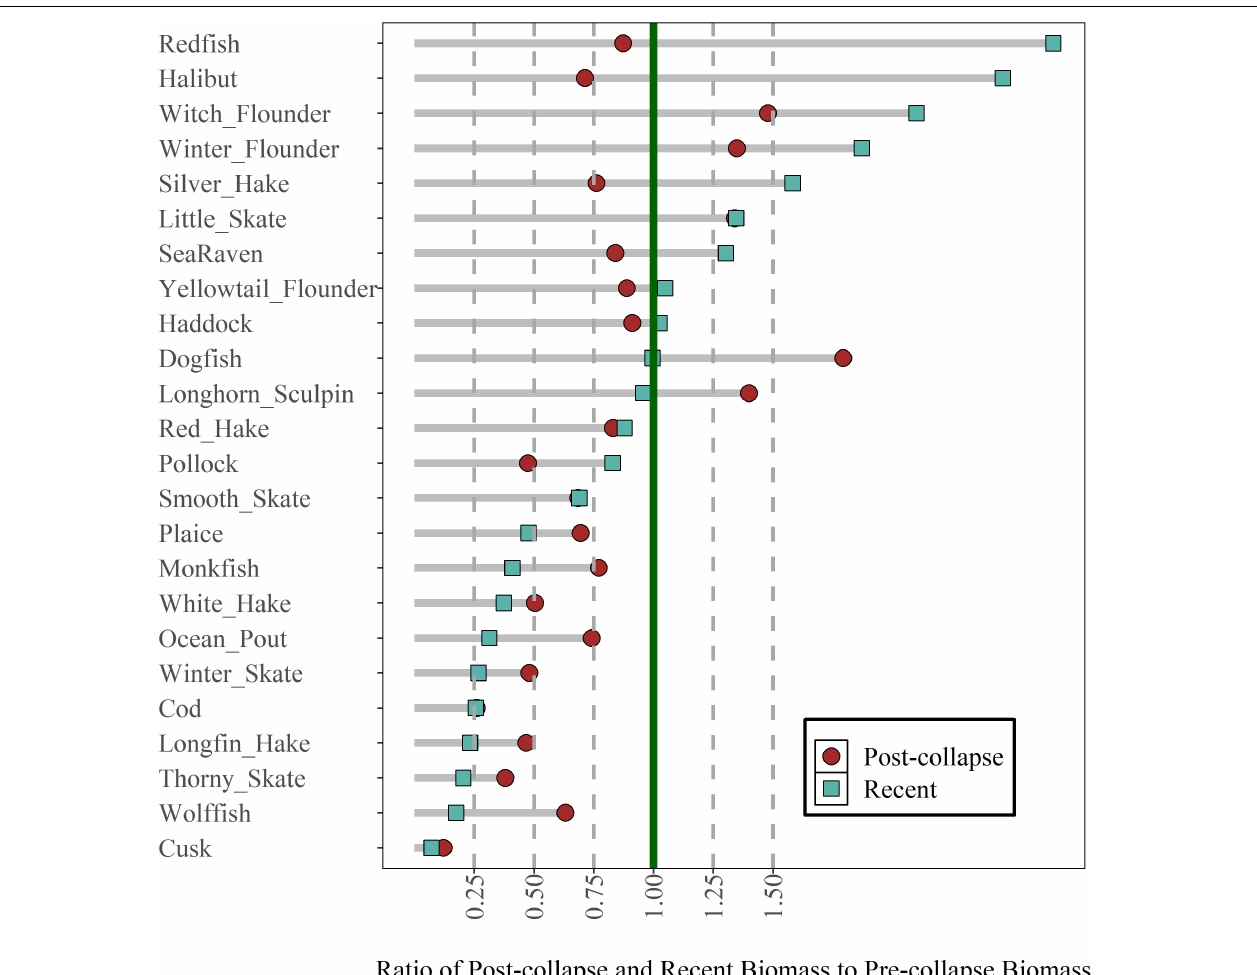
FIGURE 2 | Regional post-collapse and recent biomass status of 24 groundfish species scaled relative to the pre-collapse period. Species are ordered based on recent status (squares). See Table 1 for species full names.